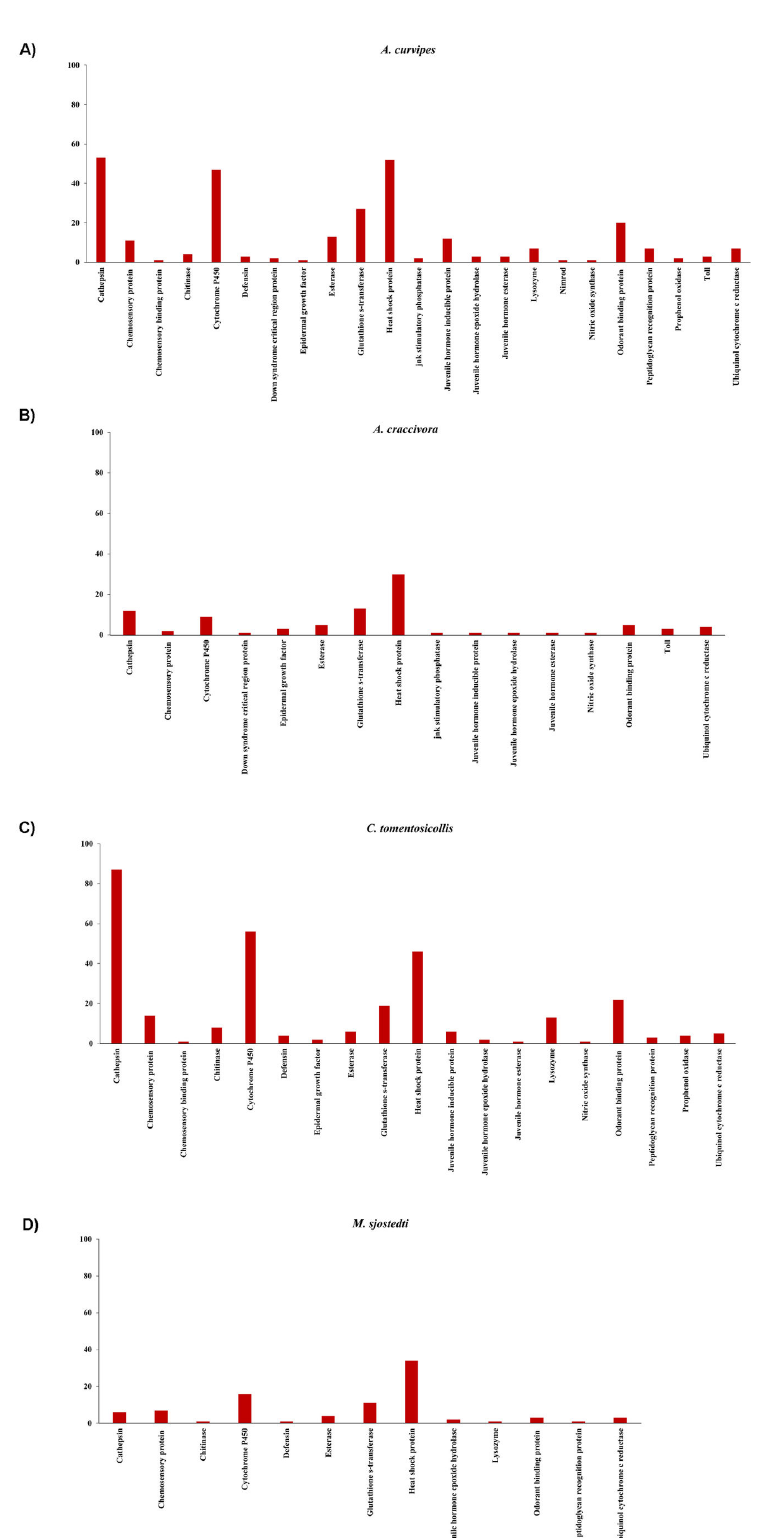
Figure 3. Transcripts putatively involved in responses to xenobiotic (e.g., insecticide resistance) and disease transmission in (a) A. curvipes , (b) A. craccivora , (c) C. tomentosicollis , (d) M. sjostedti .